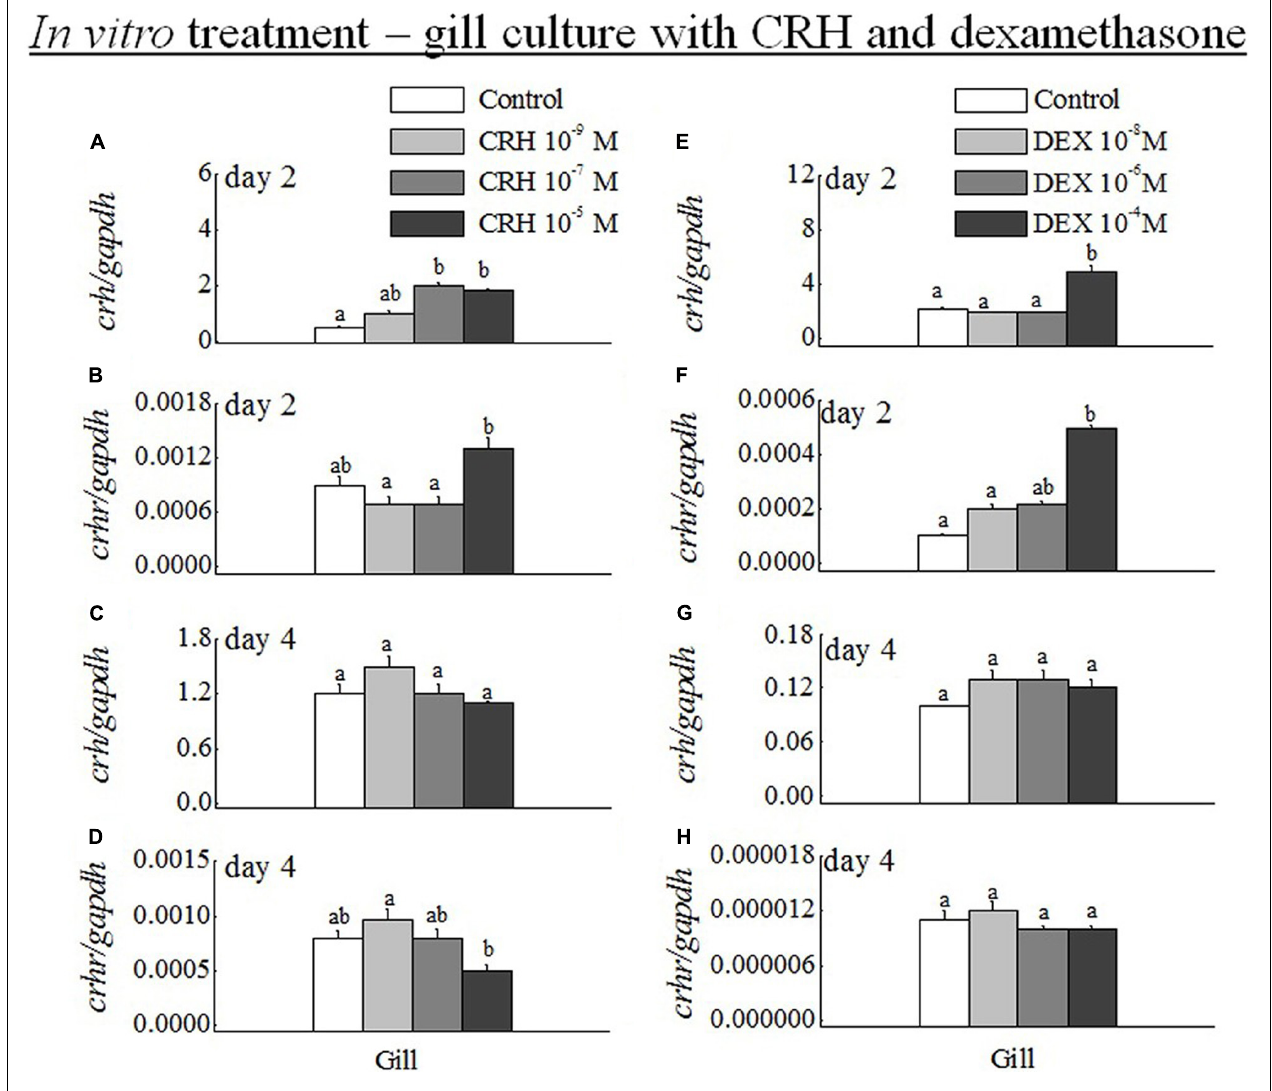
FIGURE 6 | (A–D) Q-PCR analysis was performed to examine the mRNA expression of crh and crhr in gill on day 2 (A,B) and day 4 (C,D) during in vitro gill culture with CRH low (10 − 9 M), medium (10 − 7 M) and high (10 − 6 M) doses. Data ( n = 8 for each data) are expressed as means ± standard error of the mean. The values were analyzed by one-way ANOVA, followed by a Student–Newman–Keuls multiple test, with p < 0.05 indicating a significant difference, and are denoted by “a” and “b.” (E–H) Q-PCR analysis was examined the mRNA expression of crh and crhr in gill on day 2 (E,F) and day 4 (G,H) during in vitro gill culture with DEX low (10 − 8 M), medium (10 − 6 M), and high (10 − 4 M) doses. Data ( n = 8 for each data) are expressed as means ± standard error of the mean. The values were subjected to analysis by one-way ANOVA, followed by a Student–Newman–Keuls multiple test, with p < 0.05 indicating a significant difference, are denoted by “a” and